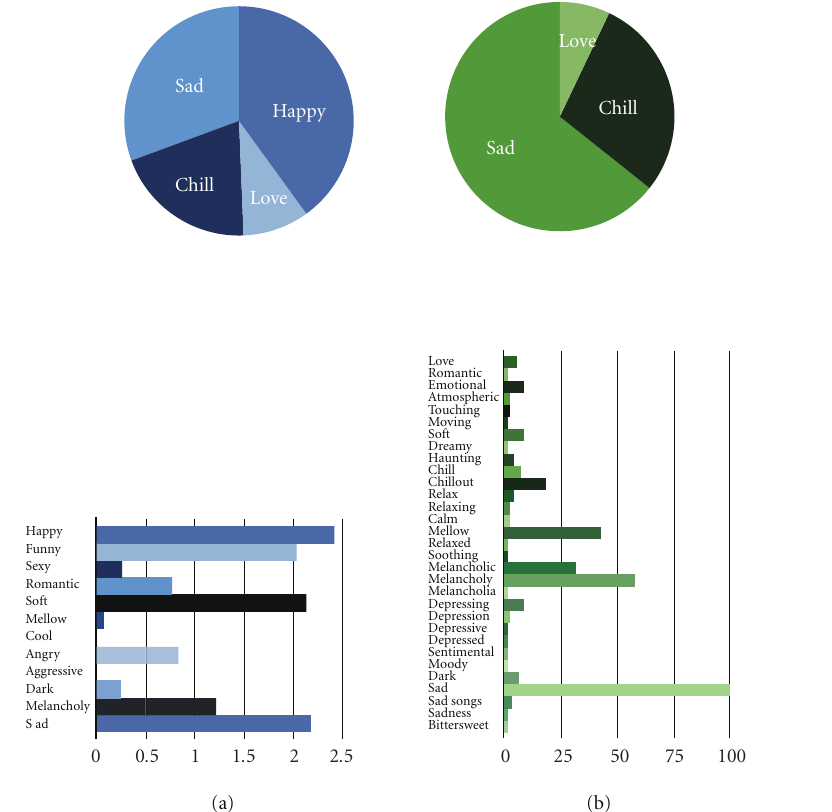
Figure 3: Accumulated LSA correlation between (a) the lyrics of the song “Mad world” and 12 a ff ective terms, compared to (b) the actual user-defined emotional tags at